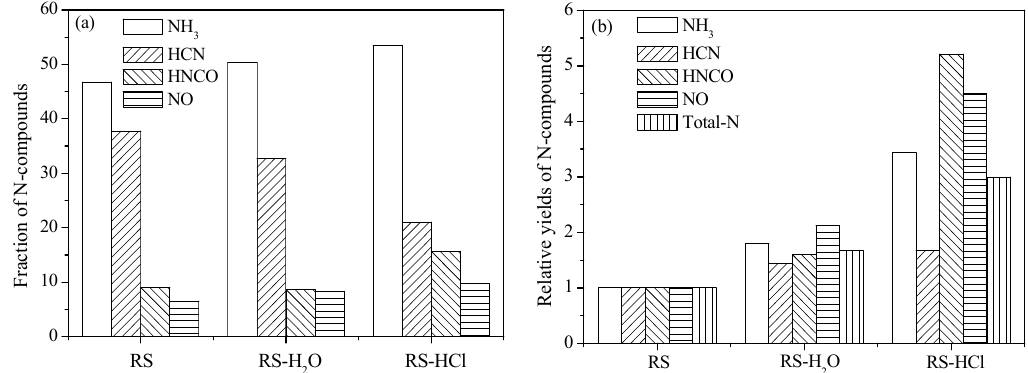
Figure 5. Selectivity and relative yields of N ‐ compounds. ( a ) Selectivity; ( b ) yield.